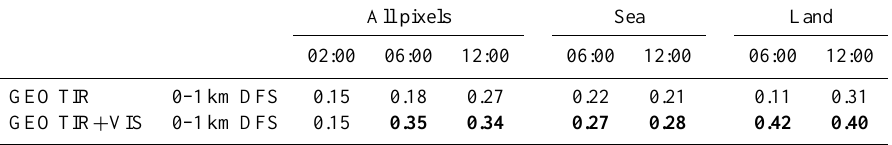
Table 2. Summary of the 0–1km degrees of freedom for signal (DFS) with GEO TIR and GEO TIR + VIS at 02:00, 06:00 and 12:00UTC for all the pixels of the red square domain (land and sea pixels together) in Fig. 2, and at 06:00 and 12:00UTC for the case of sea and land pixels. Bold values represent the highest DFS values when comparing GEO TIR and GEO TIR + VIS.